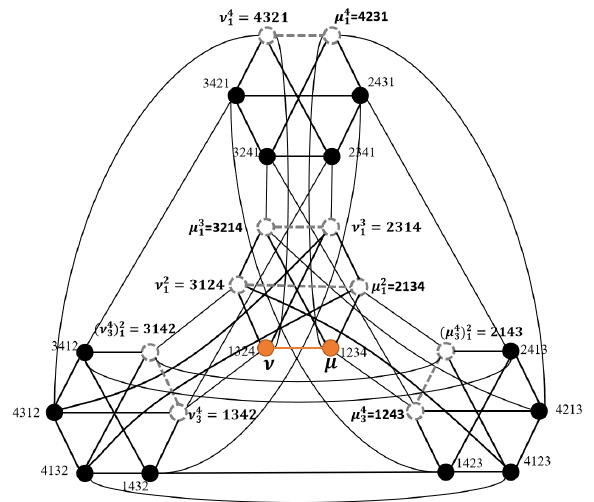
Figure 2. An example of κ ( BS n ; K 1,1 ) ≤ 2 n − 3 and κ s ( BS n ; K 1,1 ) ≤ 2 n − 3, where n =